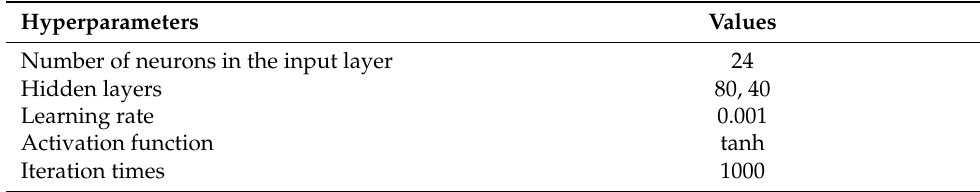
Table 2. Hyperparameters used by the ANN model.